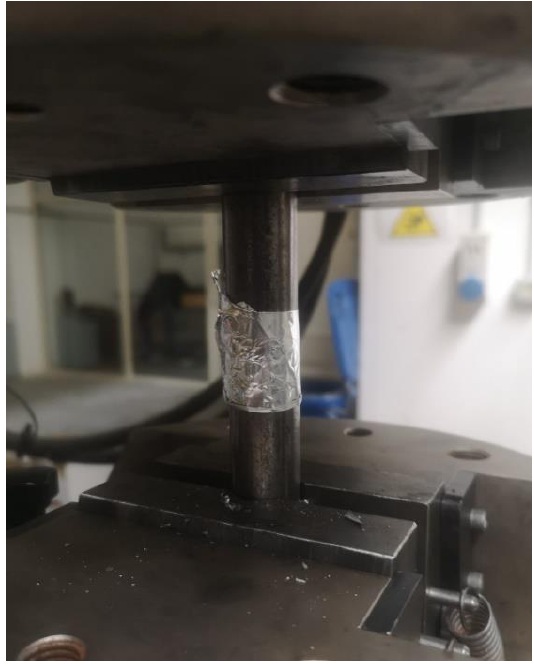
Figure 4. Picture of a specimen on the test machine.